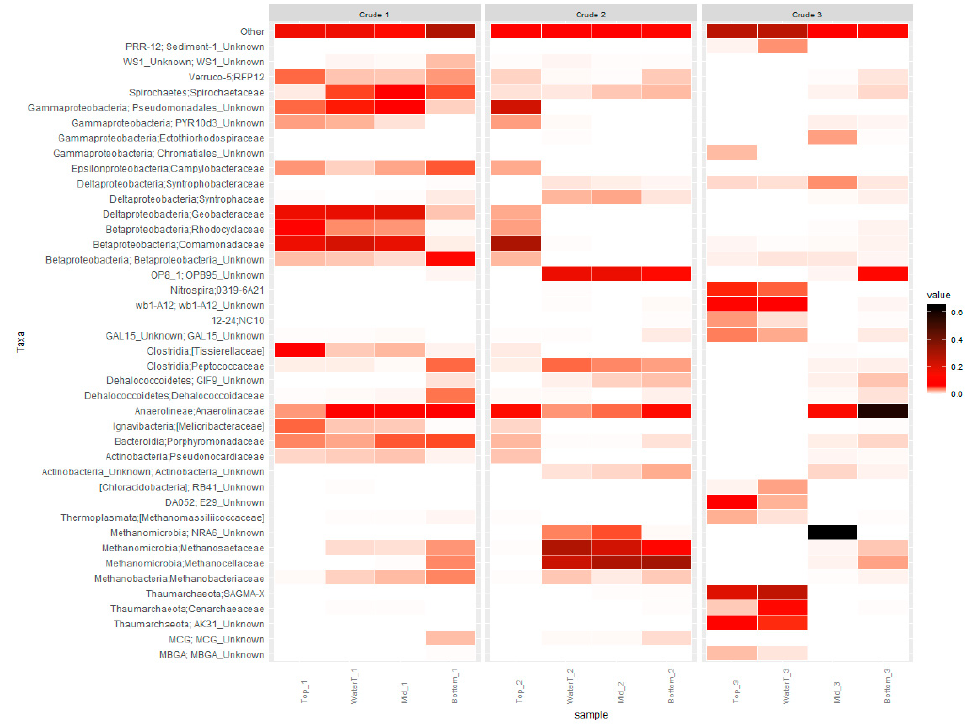
Figure 4. Most abundant taxa in crude-oil-contaminated cores. Heatmap of the most abundant (>2%) taxa in the crude-oil- contaminated cores, based on next generation sequencing of 16S rRNA genes.